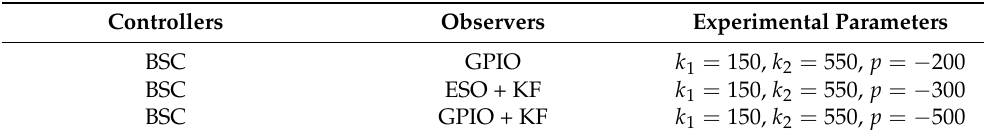
Table 2. Control parameters for DC–DC buck converter.